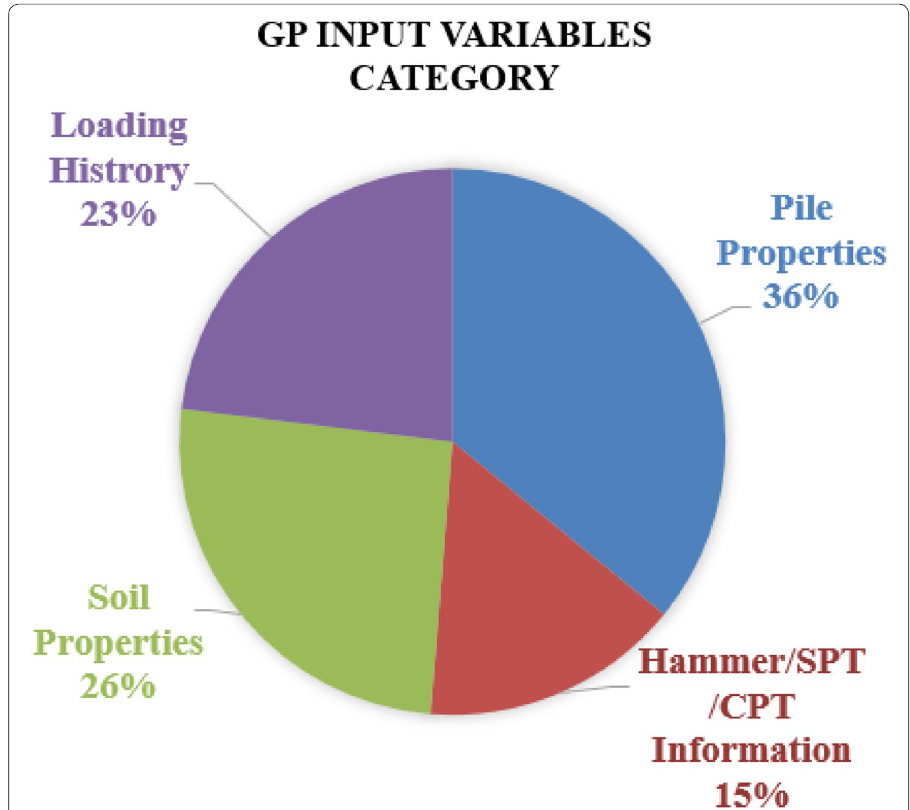
Fig. 6 Percentage of repeat for different categories of GP input